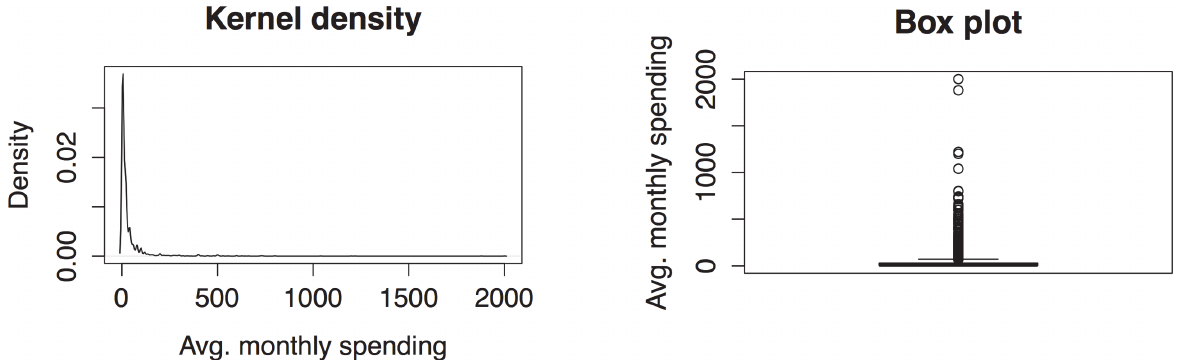
Fig 1. Kernel density plot and boxplot of nonzero values of reported lottery spending in an average month, obtained by combining the results of the Indiana, Gallup, and Texas surveys.